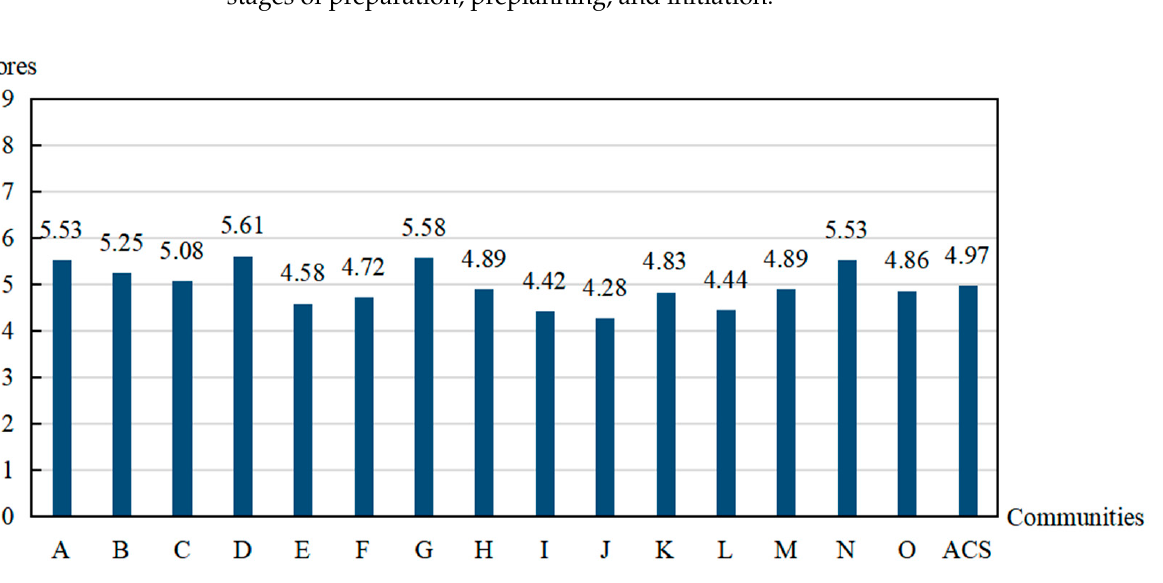
Figure 1. Community capability level. Table 4. Community readiness scores.